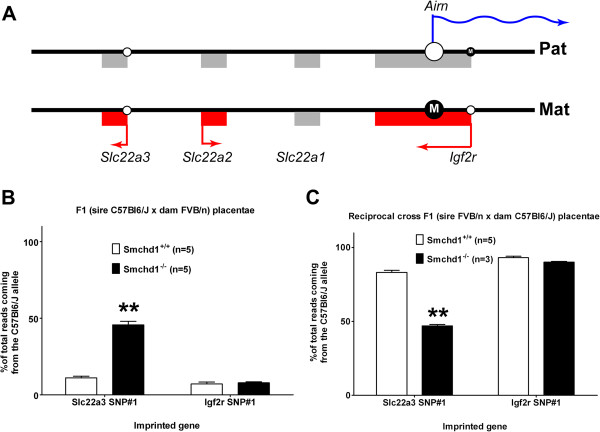
Loss of imprinting at the Igf2r imprinted gene cluster in placenta in the absence of Smchd1. (A) The Igf2r imprinted gene cluster shows imprinting in the placenta, where genes expressed from the paternal allele are shown in blue and those expressed from the maternal allele are in red. CpG islands are represented by circles on the line and where these represent an ICR (large circle) the methylation status is indicated (M inside the filled circle for the methylated allele or unfilled circle for the unmethylated allele). (B) In Smchd1+/+ F1 (C57Bl6/J sire × FVB/n dam) placental expression of both Igf2r and Slc22a3 is predominantly from the maternal FVB/n allele with only a minor proportion from the paternal C57Bl6/J allele, but in Smchd1MommeD1/MommeD1 placentas, expression of Slc22a3 becomes biallelic while expression of Igf2r remains imprinted with predominant expression of the maternal allele. (C) The same result is seen in the reciprocal cross F1 (FVB/n sire × C57Bl6/J dam) except here the maternal allele is derived from the C57Bl6/J dam. The genotype and number of replicates are indicated in each case. Statistical analysis was performed using the t test. ** P < 0.01 compared with wildtype. Error bars indicate standard error.